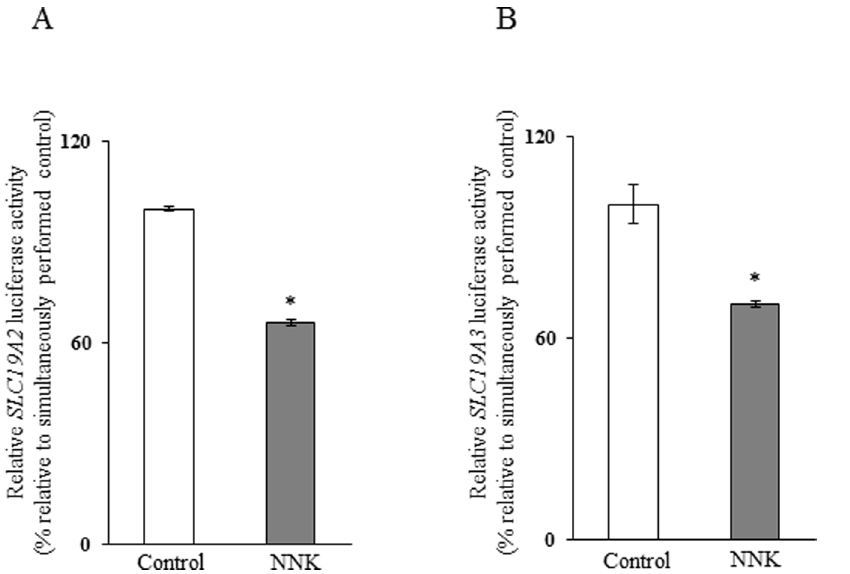
Figure 4. Effect of chronic exposure of pancreatic acinar 266-6 cells to NNK on activity of SLC19A2 and SLC19A3 promoters. Full- length SLC19A2 (A) and SLC19A3 (B) promoters in pGL3-Basic were transfected into 266-6 cells were exposed to 3 m M NNK for 24 h followed by determination of luciferase activity. Data were normalized relative to Renilla luciferase activity and presented as mean 6 SE of at least 3 independent experiments. * P , 0.01.